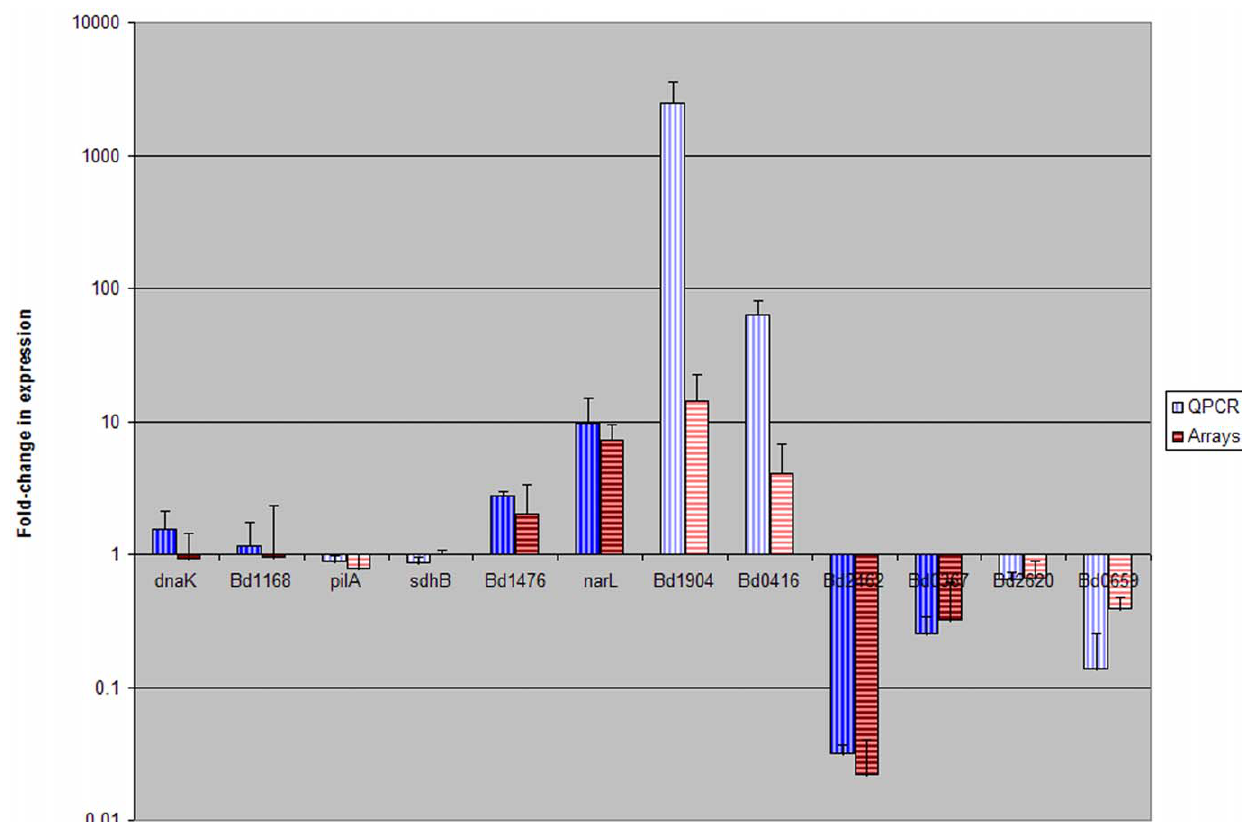
Figure 5. QRT-PCR results confirming the array results displayed on a log scale. T-test on the QRT-PCR data also showed that sdhB and pilA were not significantly differentially regulated in the transition from attack phase to predatory conditions and that dnaK and Bd1168 were not significantly differentially regulated in the transition from attack phase to HI conditions. It shows that Bd1904, Bd0416, Bd0659, and Bd2620 were significantly differentially regulated in the transition from attack phase to predatory and that narL , Bd1476, Bd2462 and Bd0367 were significantly differentially regulated in the transition from attack phase to HI. (T-test results confirmed the differences in expression between differentially regulated genes to be significant and that there were no significant differences in expression levels for those genes called as not differentially expressed in the array data). Darker colours are for genes confirming the HI array data, lighter colours for the 30 minutes predation experiment.